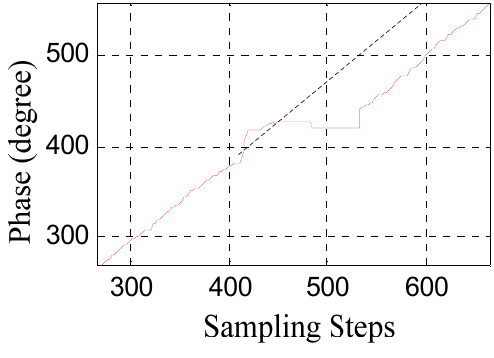
Figure 5. The converted phase